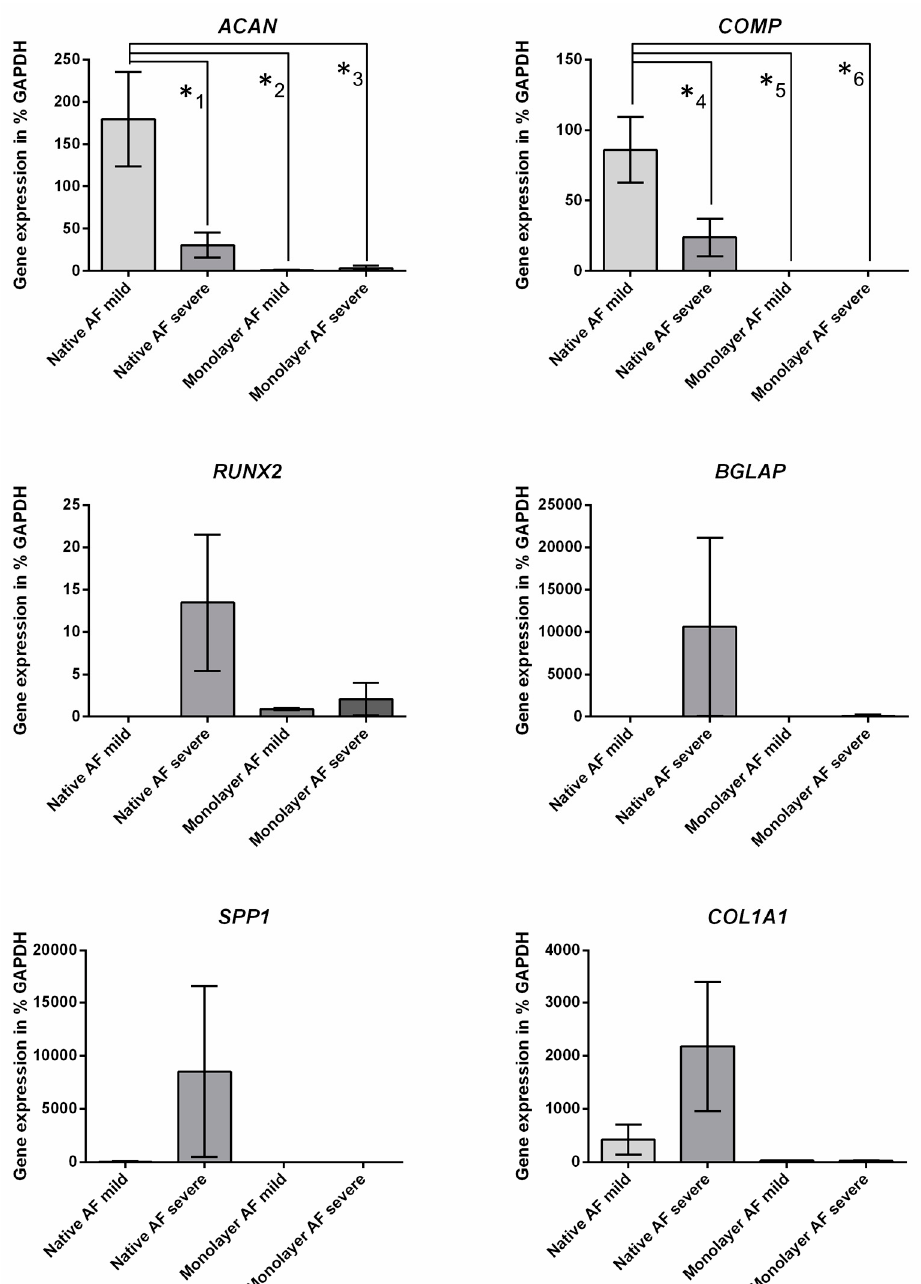
Figure 2. Real-time detection polymerase chain reaction (RTD-PCR) of chosen genes for validation microarray results of native AF tissue and monolayer cells from mild and severe degenerated intervertebral discs (IVDs). Significant differences in aggrecan (ACAN) and cartilage oligomeric matrix protein (COMP ) gene expression (* 1 p = 0.0260, * 2 p = 0.0141, * 3 p = 0.0141, * 4 p = 0.0443, * 5 p = 0.0114, * 6 p = 0.0114) (error bars SEM).